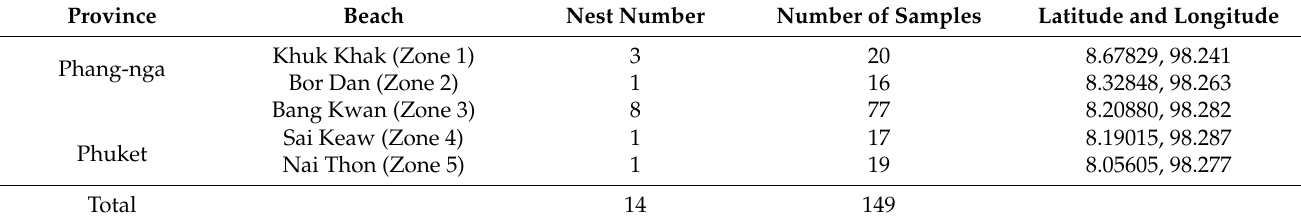
Table 1. Location and number of samples collected from leatherback turtles in each province of Thailand along the Andaman